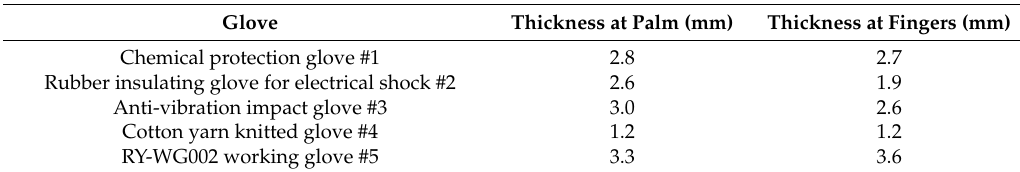
Table 2. Properties of the used industrial glove.